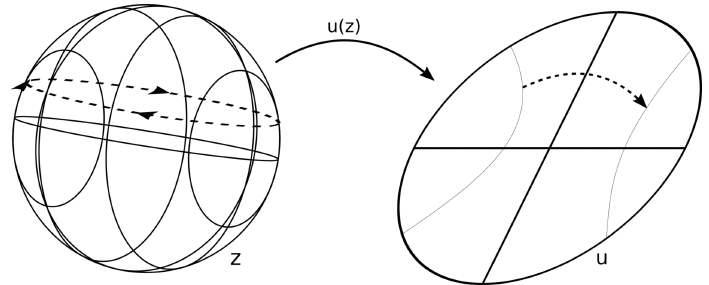
Figure 1 . The map u ( z ) functions as a map from a coordinate on the Riemann sphere to a coordi- nate on the Poincaré disk. Closed circles on the Riemann sphere map to isometry transformations on the Poincaré disk. Therefore, demanding that the metric on the Poincaré disk is single-valued as a function of z naturally implies that it describes a space given by a quotient of the Poincaré disk by the isometry transformation. A basis for u has been chosen that exemplifies the link to the BTZ